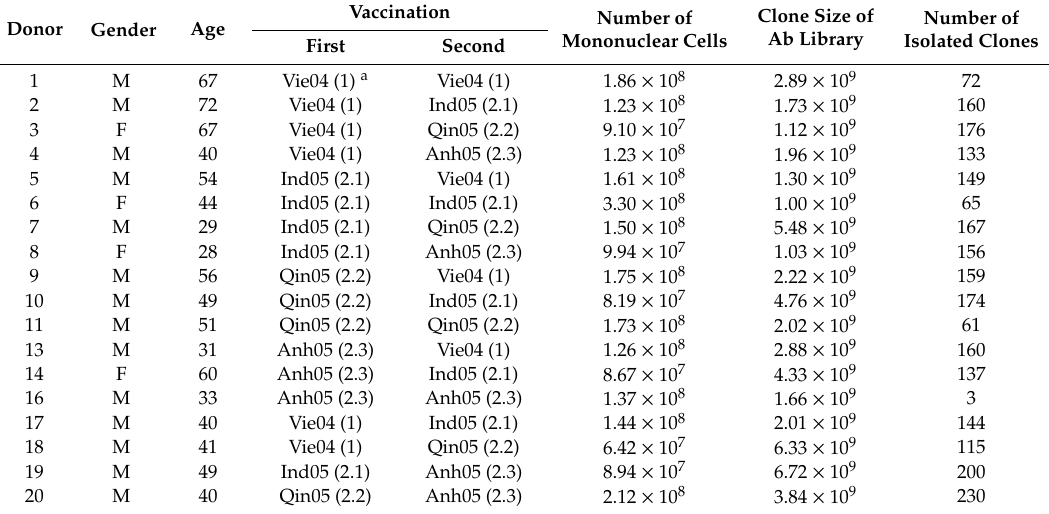
Table 1. Summary of the combination of H5N1 vaccines used for vaccination, collection of mononuclear cells, construction of Ab-encoding libraries, and isolation of